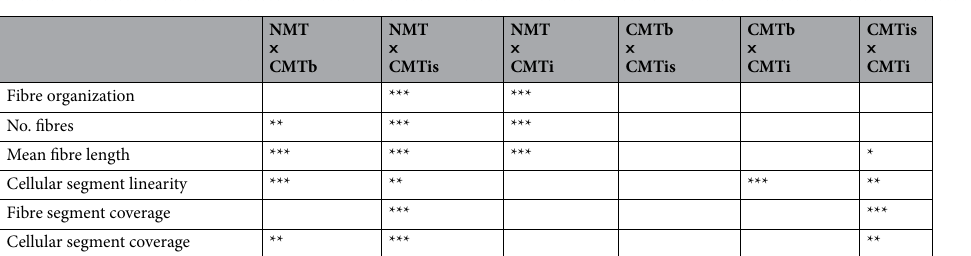
Figure 3. Boxplot graphics showing the calculated parameters for the fibre and cell segments: the fibre organization, number of fibres, the mean fibre length, the cellular segment linearity, the fibre segment coverage and the cellular segment coverage for the NMT, CMTis and CMTi regions of the CMT. The centre lines show the medians, the box limits indicate the 25th and 75th percentiles, the whiskers extend 1.5 times the interquartile range from the 25th and 75th percentiles and the outliers are represented by dots.